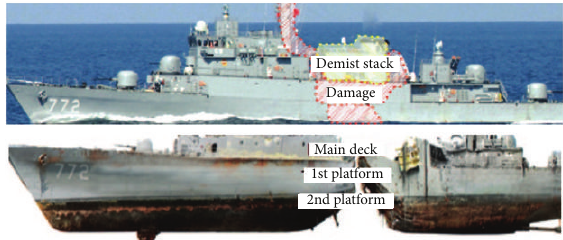
Figure 1: Example of Cheonan Naval Ship damage after close-in UNDEX